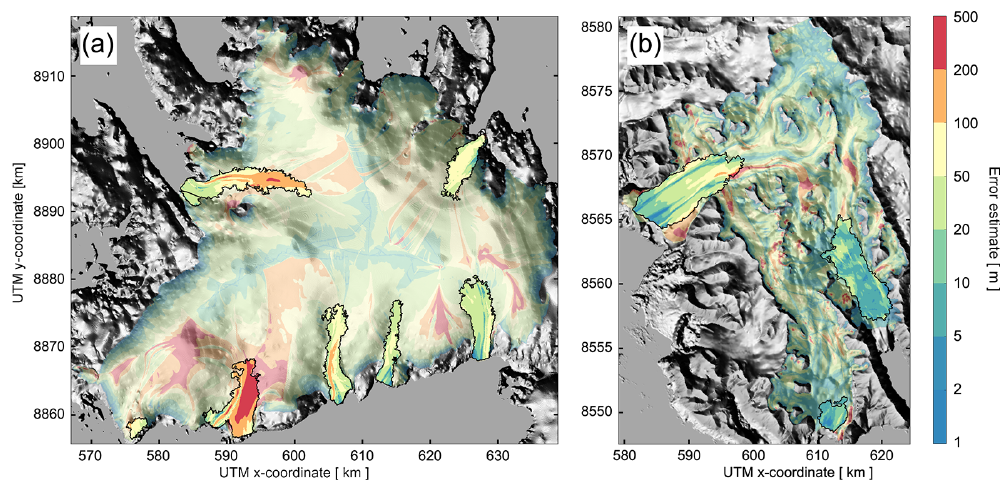
Figure 9. Error-estimate map as in Fig. 6 for VIC (a) and THPB (b) . Partially transparent areas in the thickness maps (unsaturated colours) stem from the first-step reconstruction, for which ice thickness is inferred from the ice-flux solution. Along the outlet glaciers (non-transparent lurid colours), error estimates are updated relying on velocity observations (Fig. 2c and